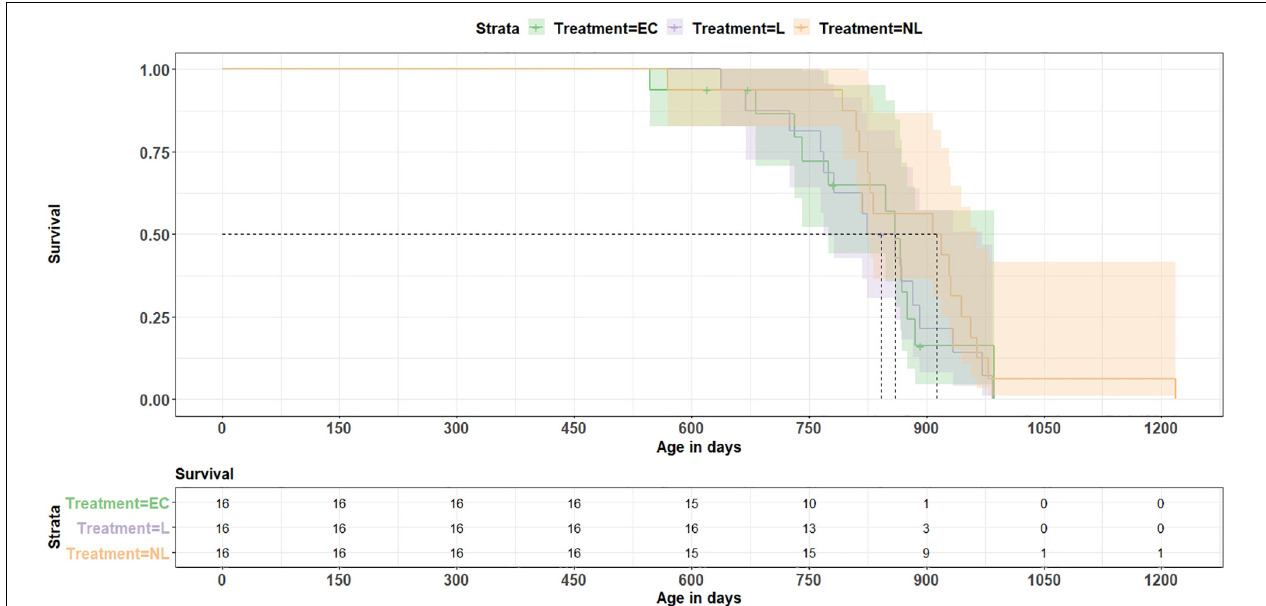
FIGURE 9 | Survival analysis. The data show no treatment effect (EC = equipment control group, L = learner, NL = non-learner) on survival ( p = 0.43). Dashed lines indicate median length of survival for each treatment group.